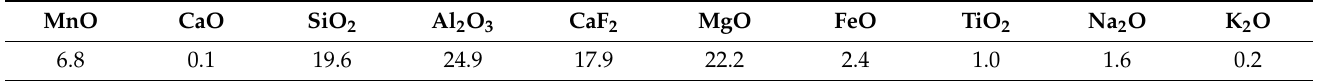
Table 2. Flux bulk chemical composition (mass%) [28].